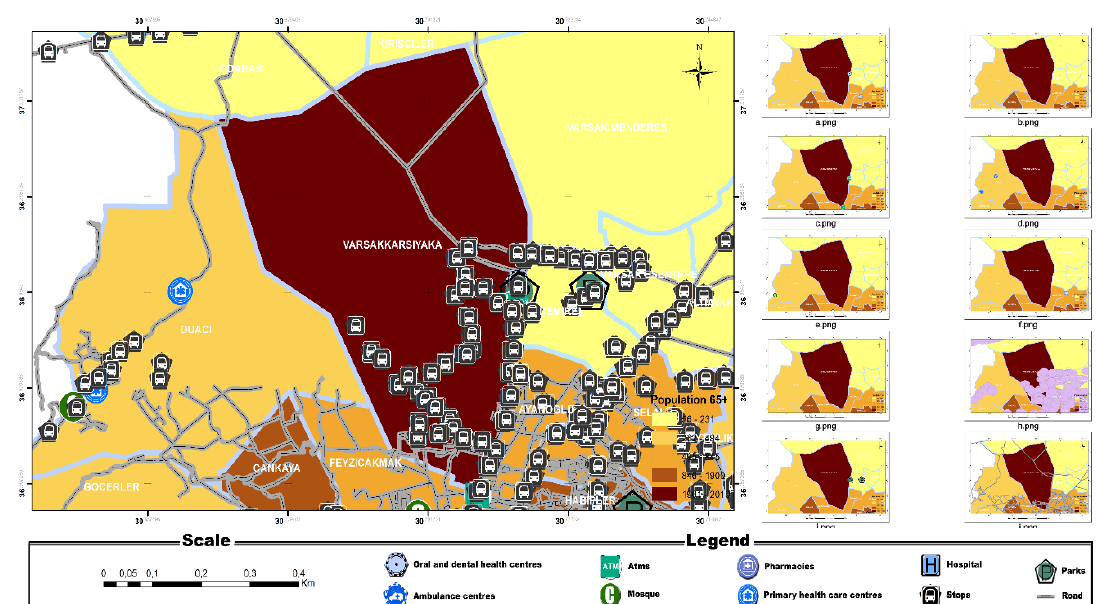
Figure 7. Location and density map of selected criteria in Varsak